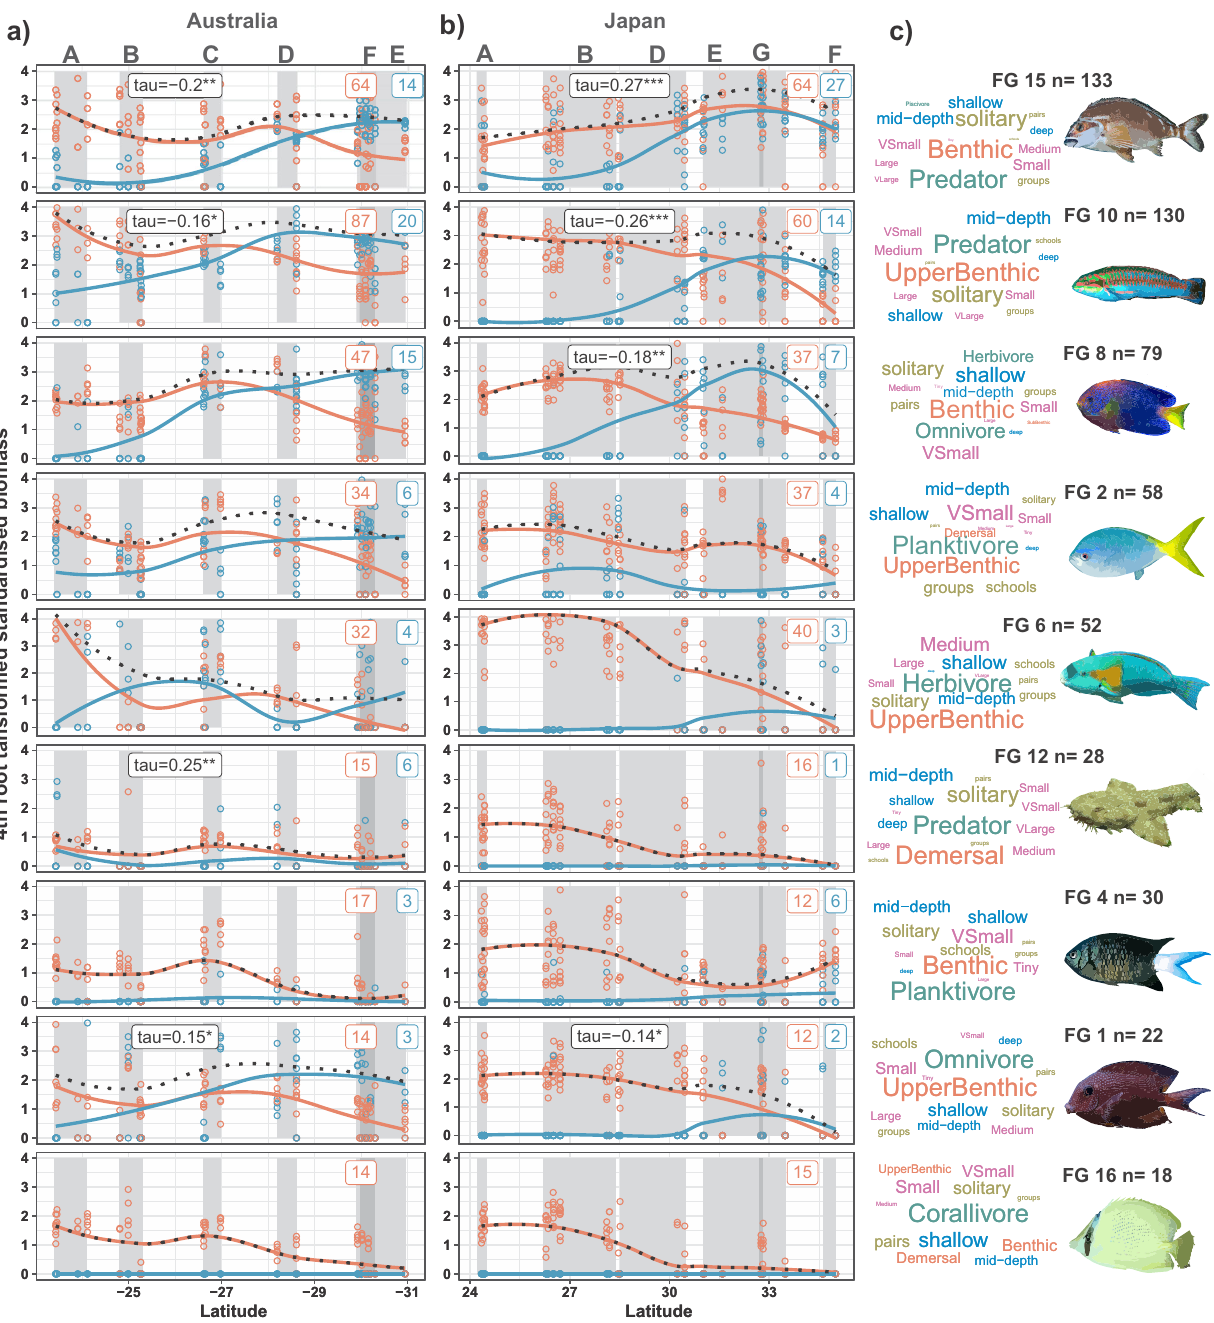
clouds denote the traits characterising each functional group, where larger word sizeshowshigherimportanceofatraitinde fi ningthegroup,coloursdenotetraits: diet=green; habitat association=red; body size=pink; aggregation=yellow; and depthrange=blue.Fishiconshighlightatypicalmemberofeachfunctionalgroup. Transitionalcommunityzonesarecoded:A=TropicalCoralReef,B=Cold-tropical Reef, C=Warm-transitional Reef, D=Transitional Reef, E=Subtropical Reef, F= Temperate Kelp Reef, G=Cold-transitional Reef. Fish icons depict species char- acteristics for the functional groups, created in CorelDraw 16 from original pho- tographs by the authors. Source data are provided as a Source Data fi